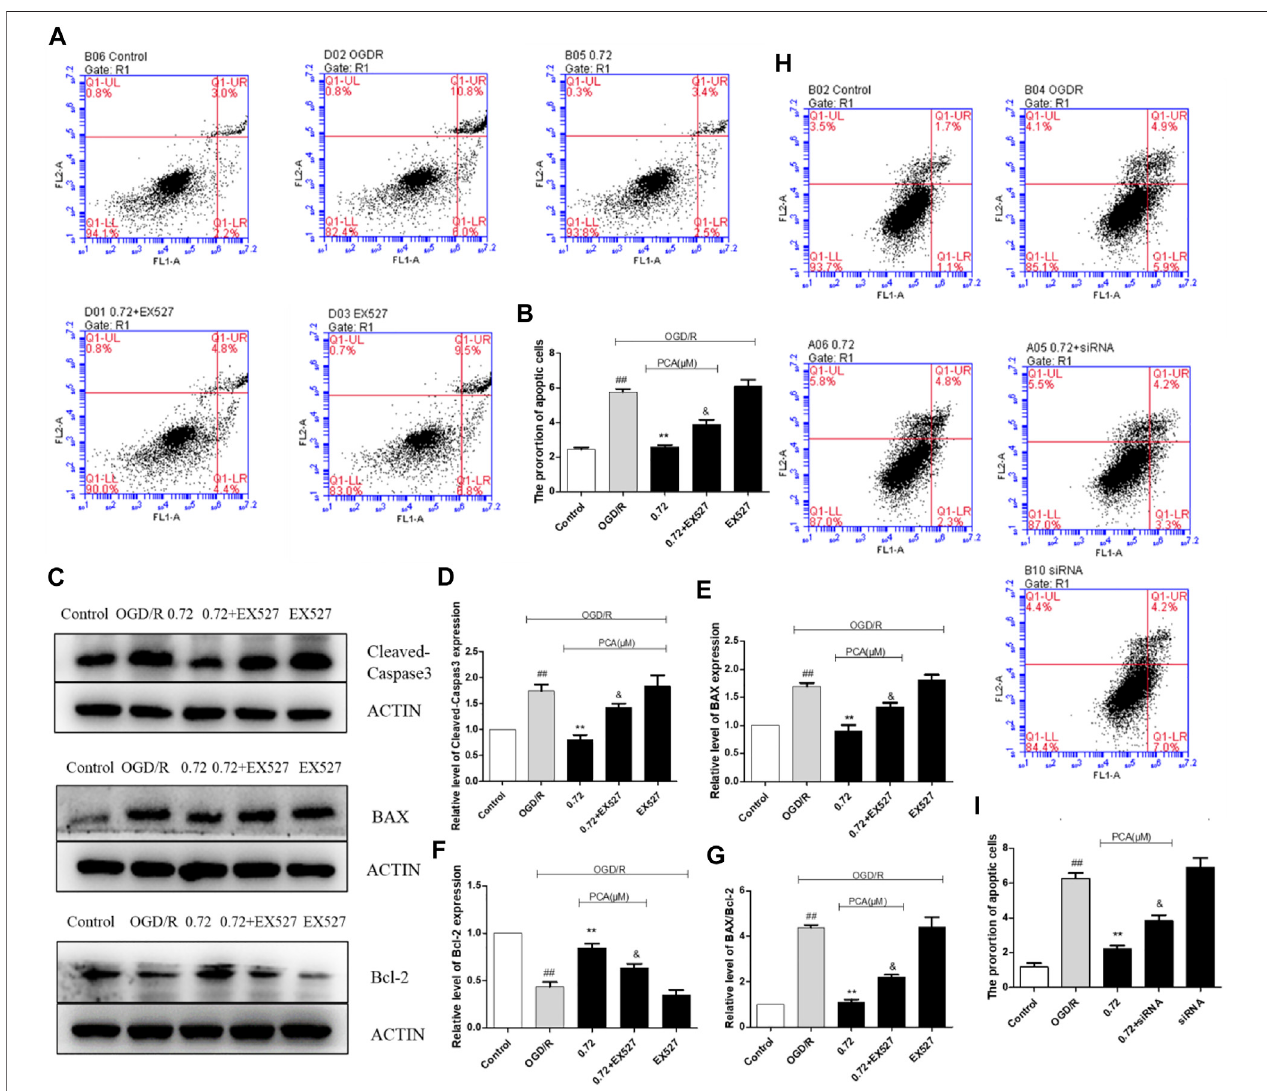
FIGURE 9 | Inhibition of SIRT1 by EX527 attenuates the anti-apoptotic effect of PCA. (A, B) Representative images of fl ow cytometry analysis of EX527 in fl uence and quanti fi cation ofcell apoptosis rate. (C – G) Representative images ofWBanalysisand thesemi-quanti fi cation ofCleaved-Caspase3, BAX and Bcl-2 inHUVECs. (H, I) Representativeimagesof fl owcytometryanalysisofsiRNAin fl uenceandquanti fi cationofcellapoptosisrate.Thevaluesareexpressedasthemean±SD( n =3). ## p < 0.01 vs. Control, ** p < 0.01 vs. OGD/R, & p < 0.05 vs. PCA 0.72 μ